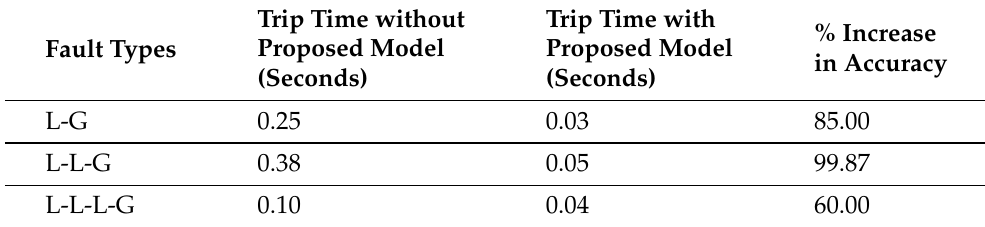
Table 7. Percentage accuracy of the proposed model at bus A.